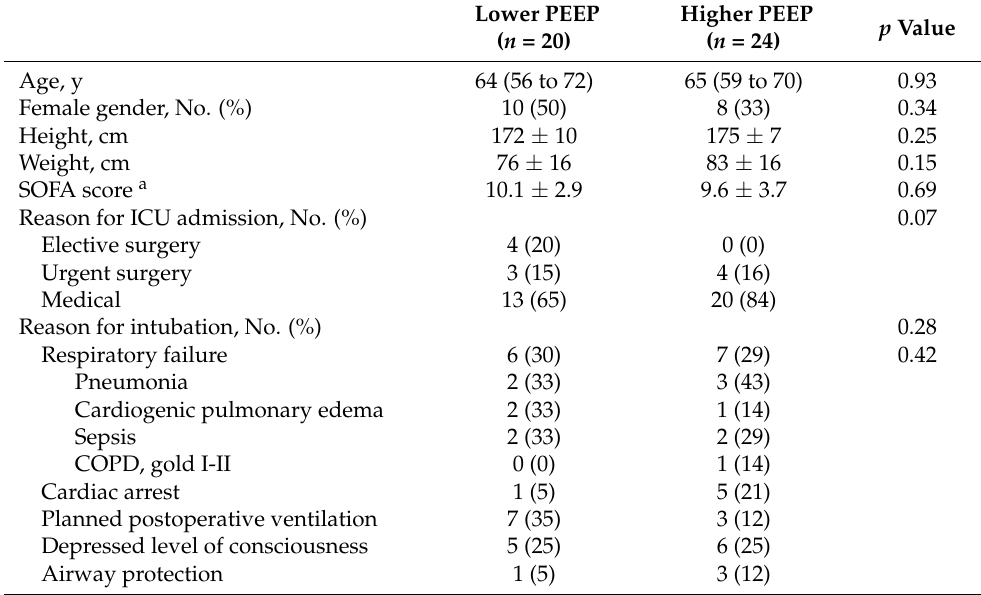
Figure 1. Flow of patients. Abbreviations: PEEP, positive end-expiratory pressure. Table 1. Baseline characteristics of the